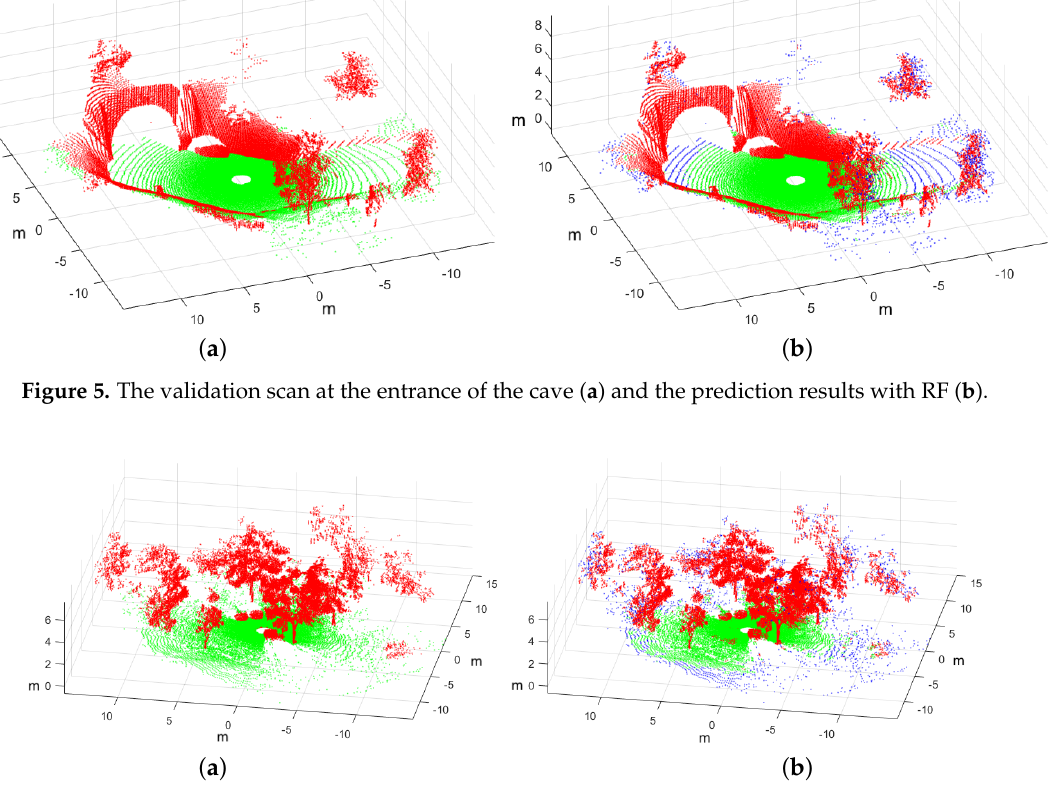
Figure 6. The validation scan inside the forest ( a ) and the prediction results with RF ( b ).